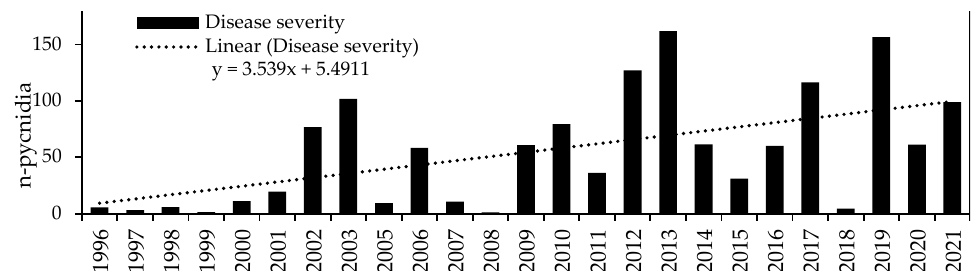
Figure 2. RWAUDPC (xF−0–x-F−2 = 33%; xF−3–x-F−6 = 0%) of STB (n-pycnidia) of the observation period (GS 30 to GS 77) from the survey period at the trial location. Dotted line describes the linear regression of disease severity.